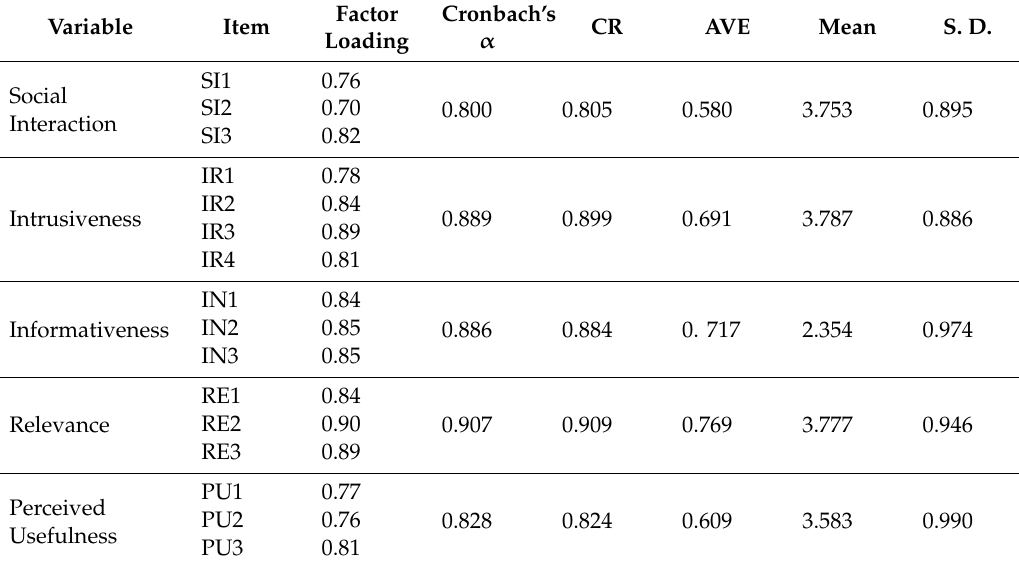
Table 4. Statistics of construct